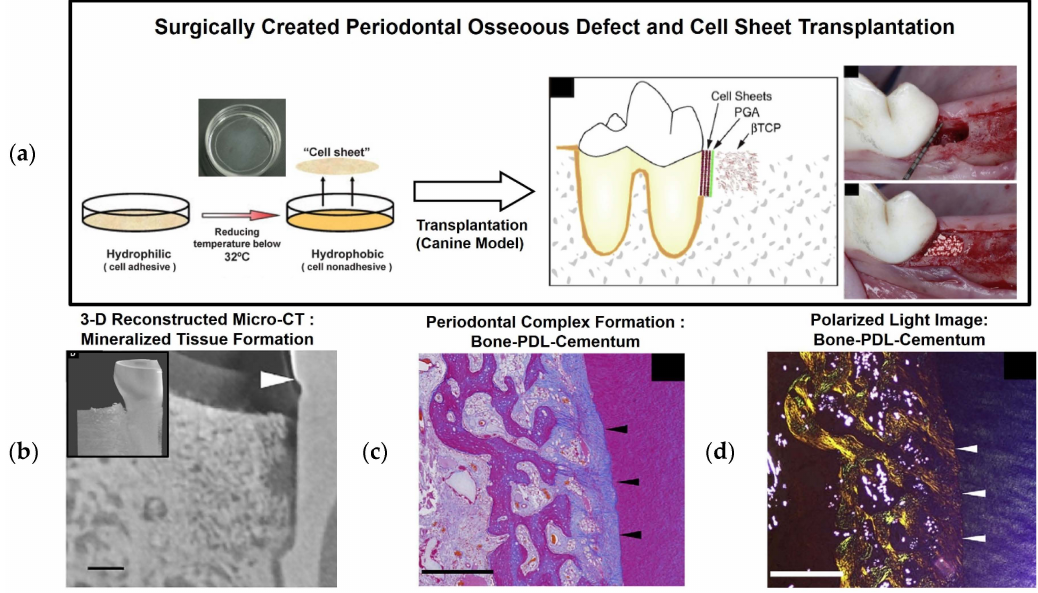
Figure 2. Surgical creation of a three-wall defect in a canine model. After cultivating and harvesting cell sheets, a PGA (poly-glycolic acid) membrane was placed on the tooth-root surface, and β -tricalcium phosphate ( β -TCP) was used to fill in the defect ( a ) [26,27]. ( b – d ) Micro-computed tomography (Micro-CT) and histology were performed to assess bone regeneration and mineralized tissue formation on the root surface. Moreover, histological and polarized microscopic images demonstrated PDL regeneration with oblique orientations and periodontal attachment. The scale bars: 1 mm for ( b ) and 500 µ m for ( c , d )